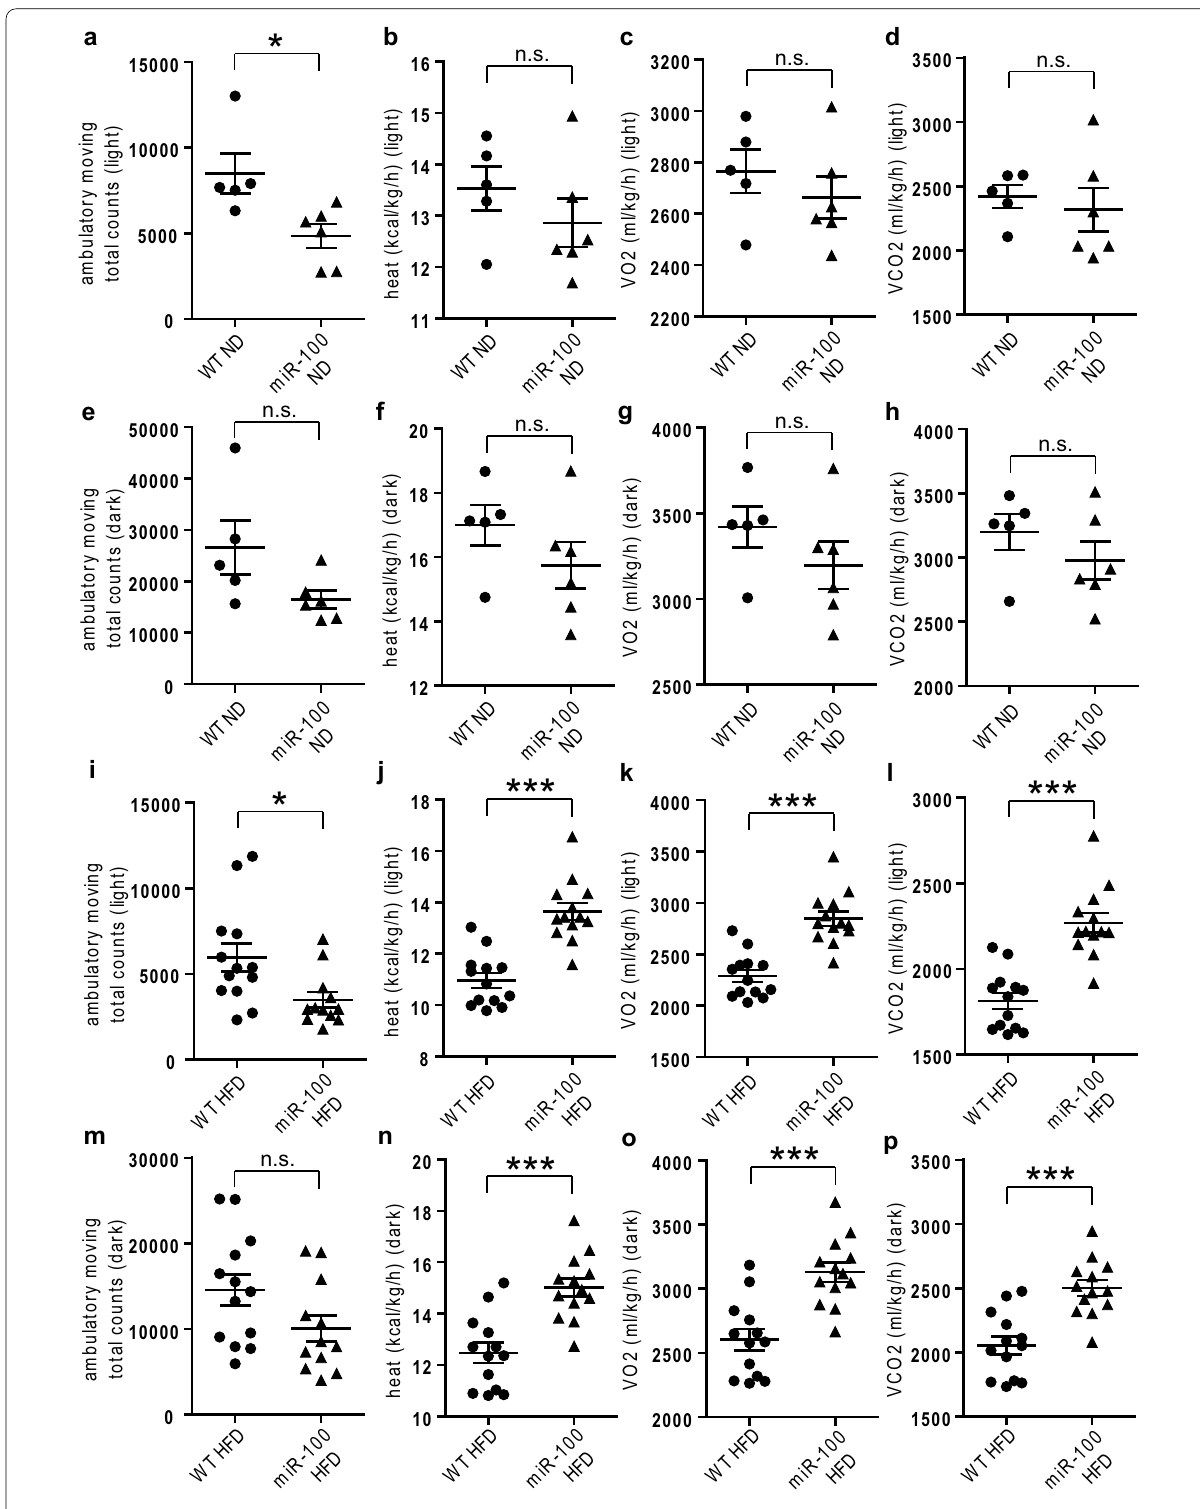
Fig. 7 (See legend on previous